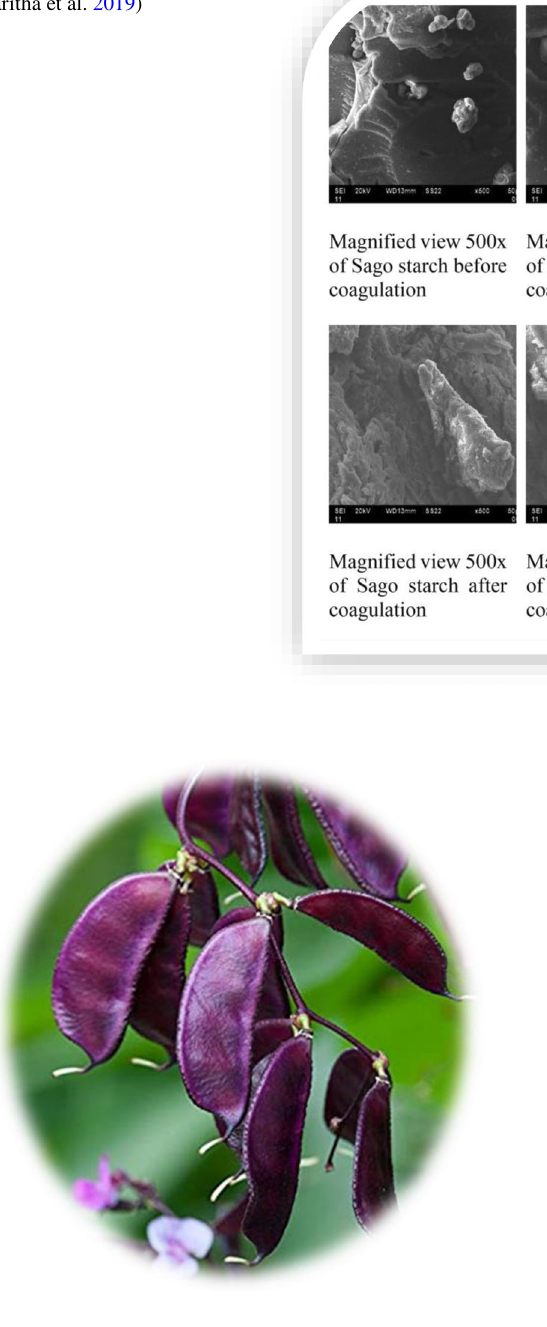
Fig. 12 Sago SEM images showing adsorption of impuri- ties (Saritha et al. 2019)